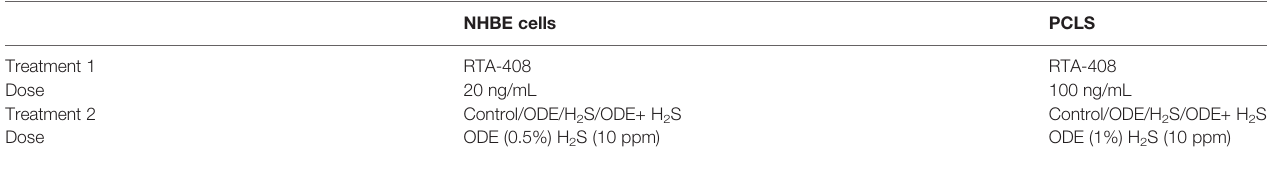
TABLE 1 | Experimental design.